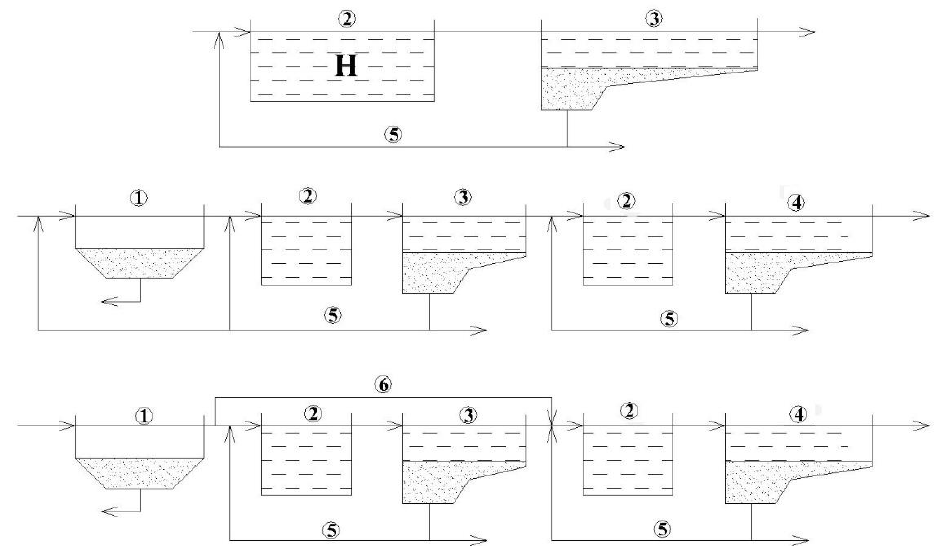
Figure 1. One-stage and two-stage activated sludge systems for nitrification: 1 — primary clarifier